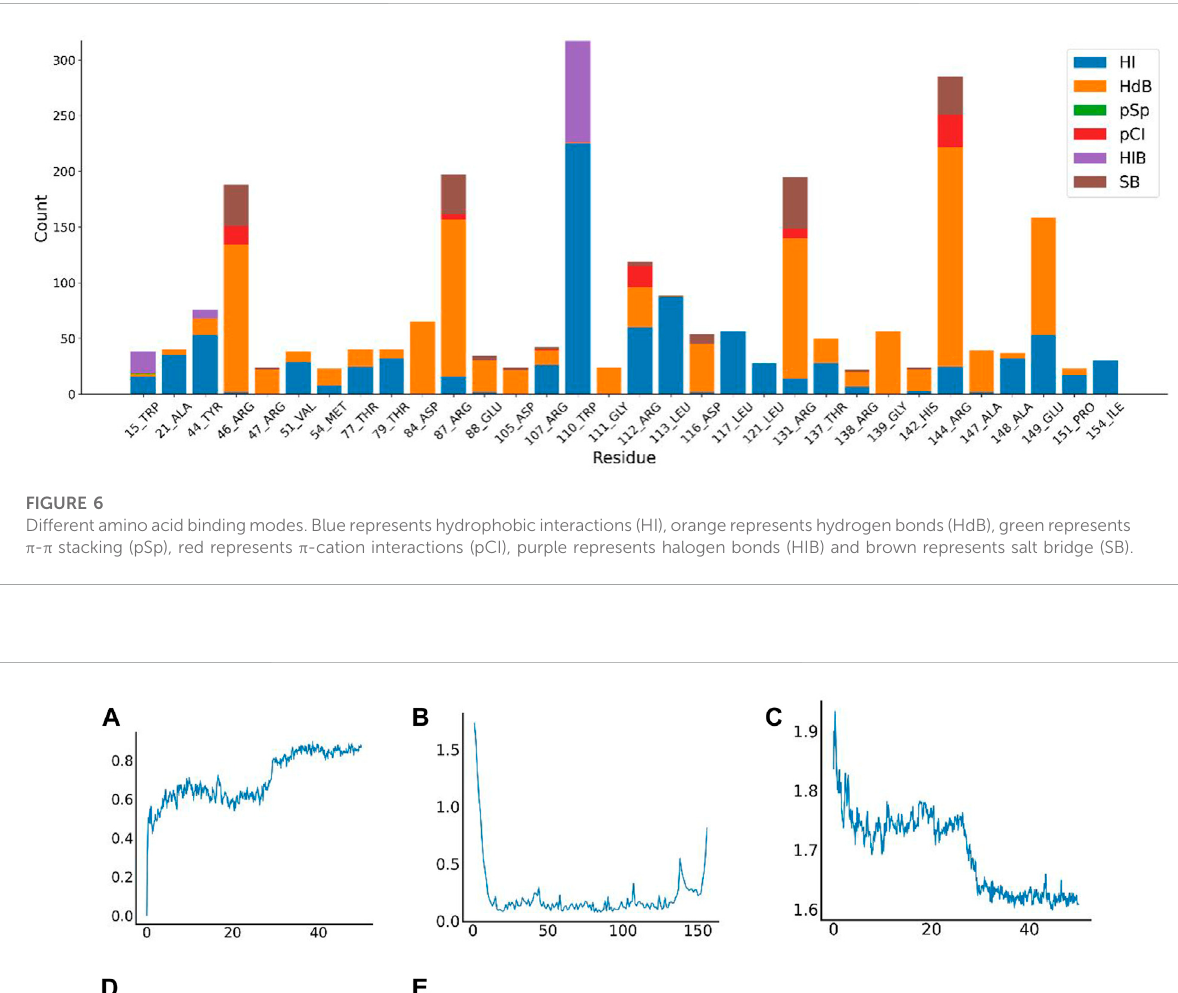
prognosis of various tumours, including hepatocellular carcinoma, pancreatic cancer and melanoma (Zeng et al., 2018; Kimura et al., 2021; Luo et al., 2021). Copy number deletion in CDKN2A and low expression of p16INK4a indicate a poor prognosis and can be used as independent